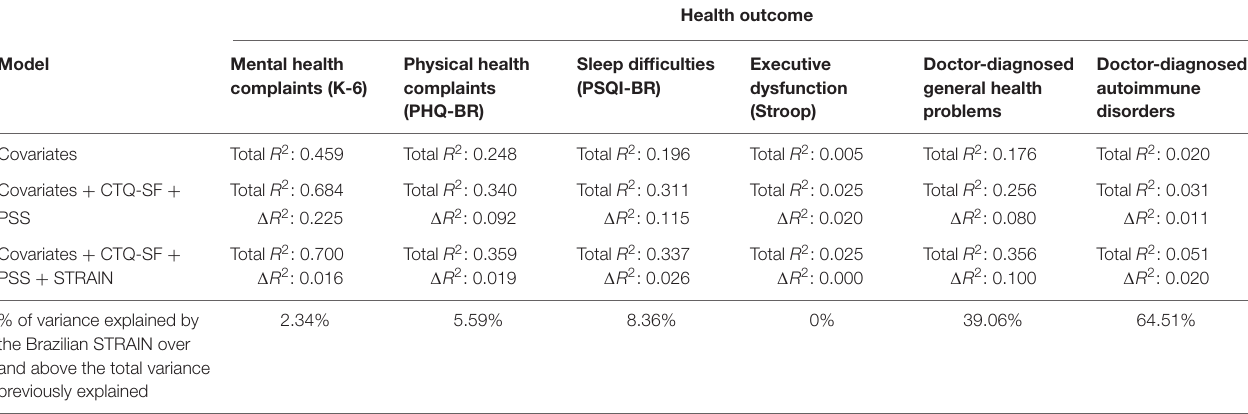
TABLE 3 | Incremental validity of the STRAIN over the CTQ-SF, PSS, and relevant covariates.